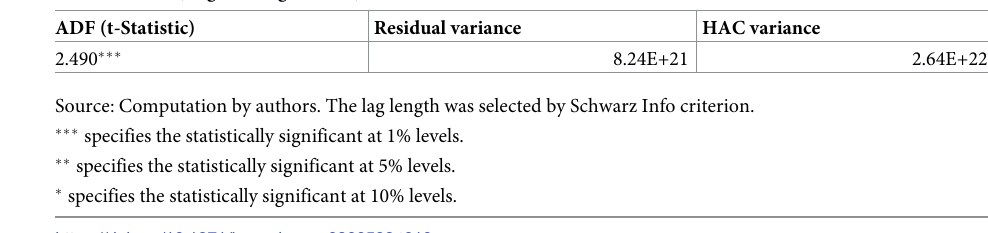
Table 10. Kao (Engle Granger based) test.